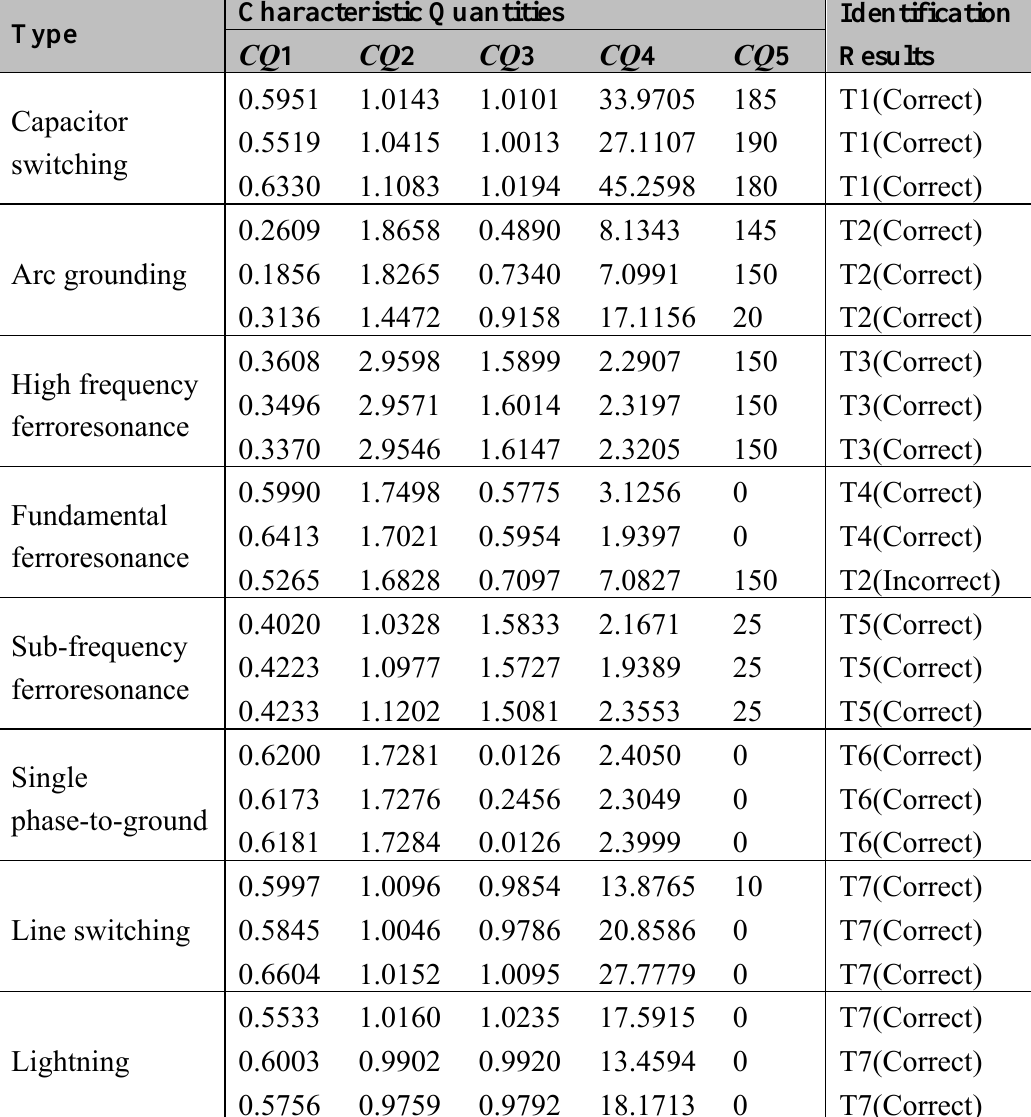
Table 5. Characteristic quantities and identification results of 24 field